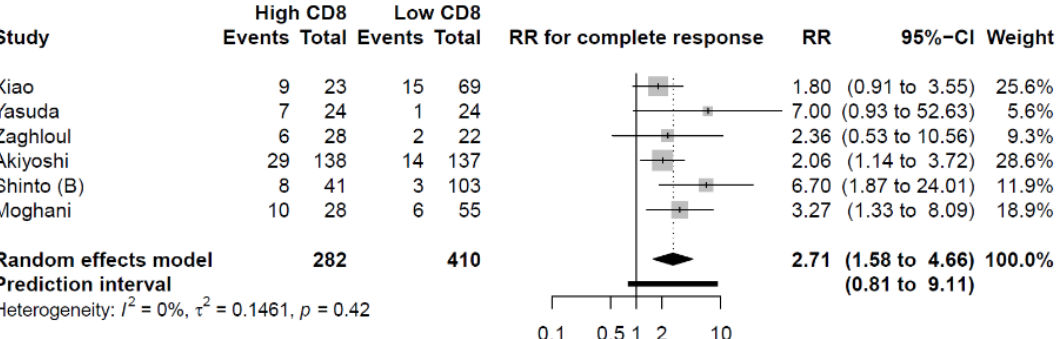
Figure 2. The relationship between CD8 + TILs density and pCR. Patients with high pretherapeutic CD8 + TILs density had a significantly increased likelihood of achieving a pCR. RR: Risk Ratio.